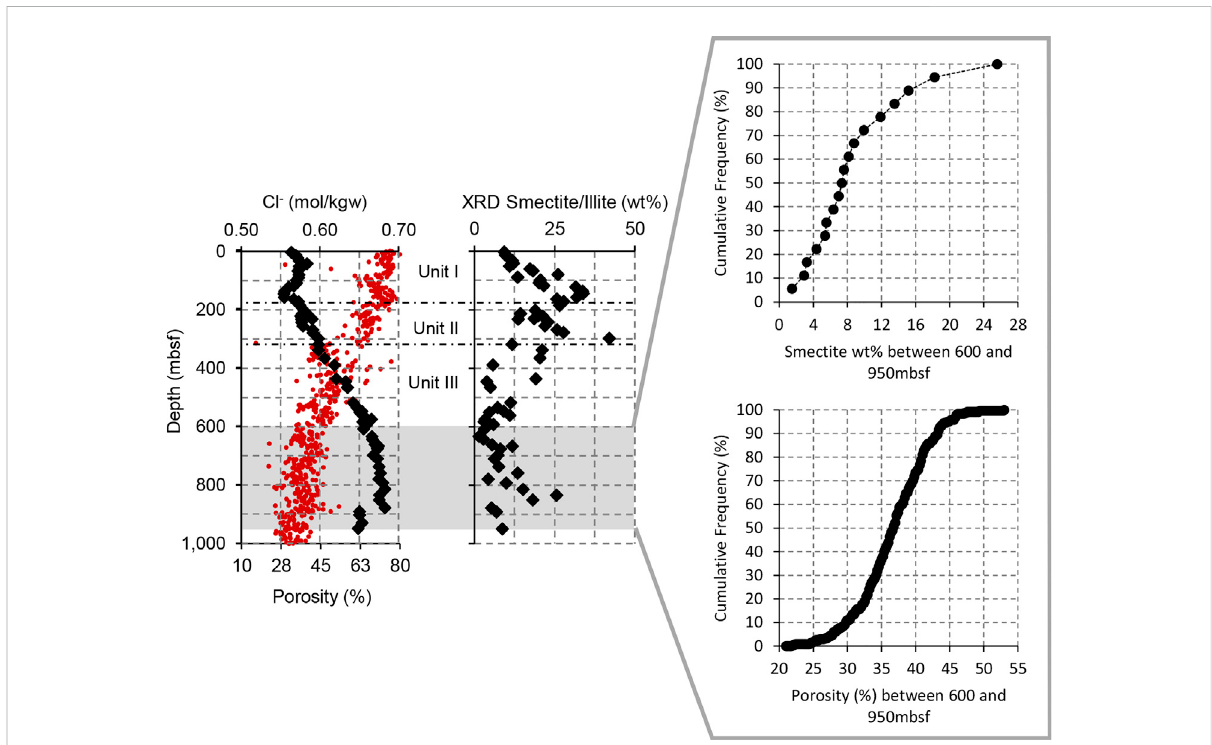
FIGURE 6 Depth pro fi les of observed porewater chloride (black diamonds), sediment porosity (red circles) and XRD-estimated content of smectite; and, the cumulative frequency curves of sediment porosity and XRD-estimated content of smectite for the depth interval with the highest chloride concentration — 600 to 950